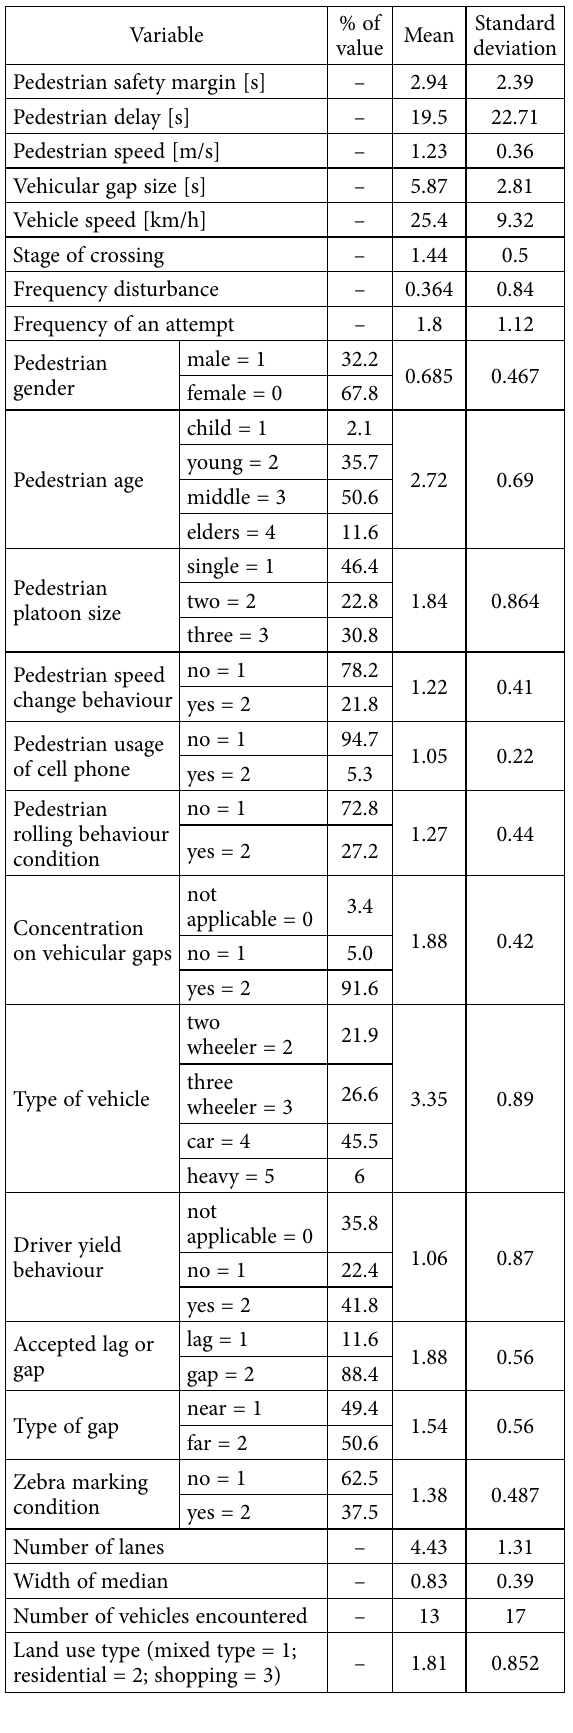
Table 2. Descriptive statistics of selected